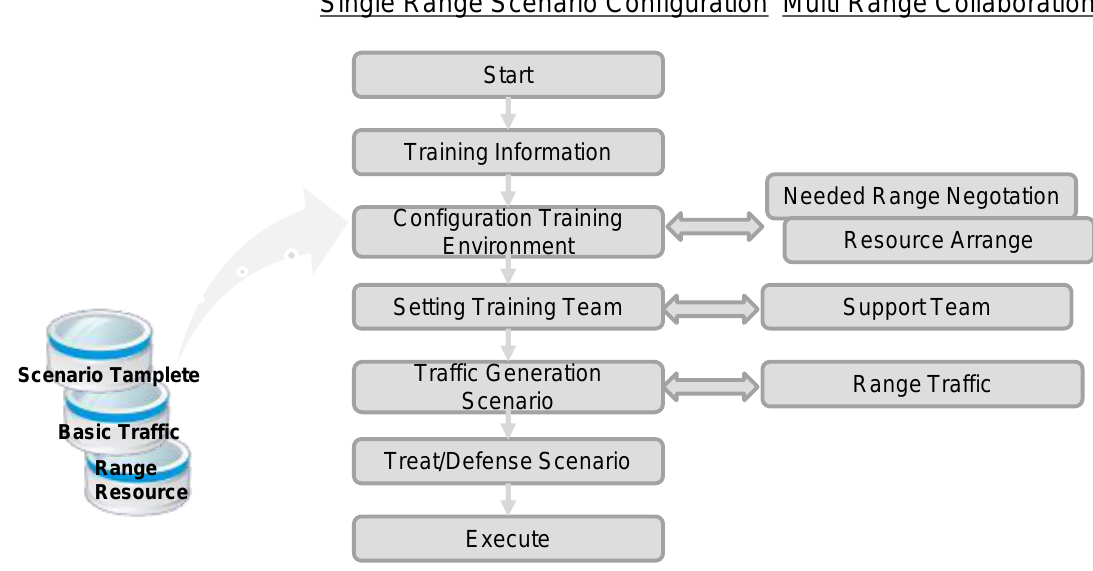
Figure 4. Procedure for Scenario Authoring.